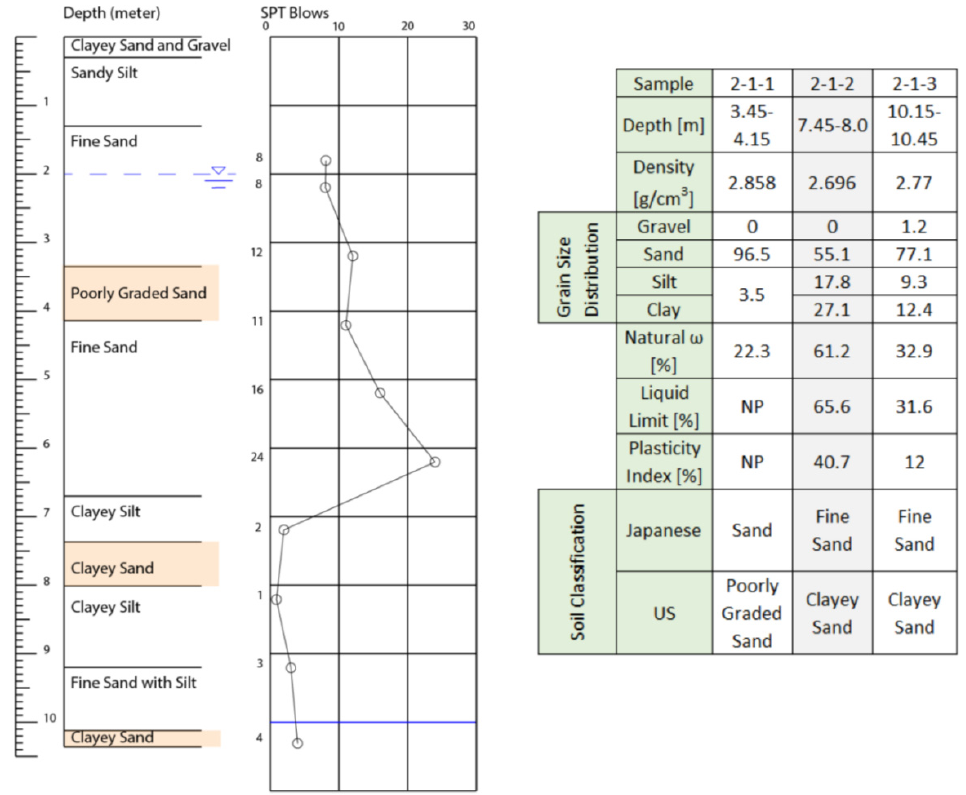
Figure 11. SPT characterization, interpreted soil profile, and laboratory index test results for Site 2-1 (after Anderson [40]).